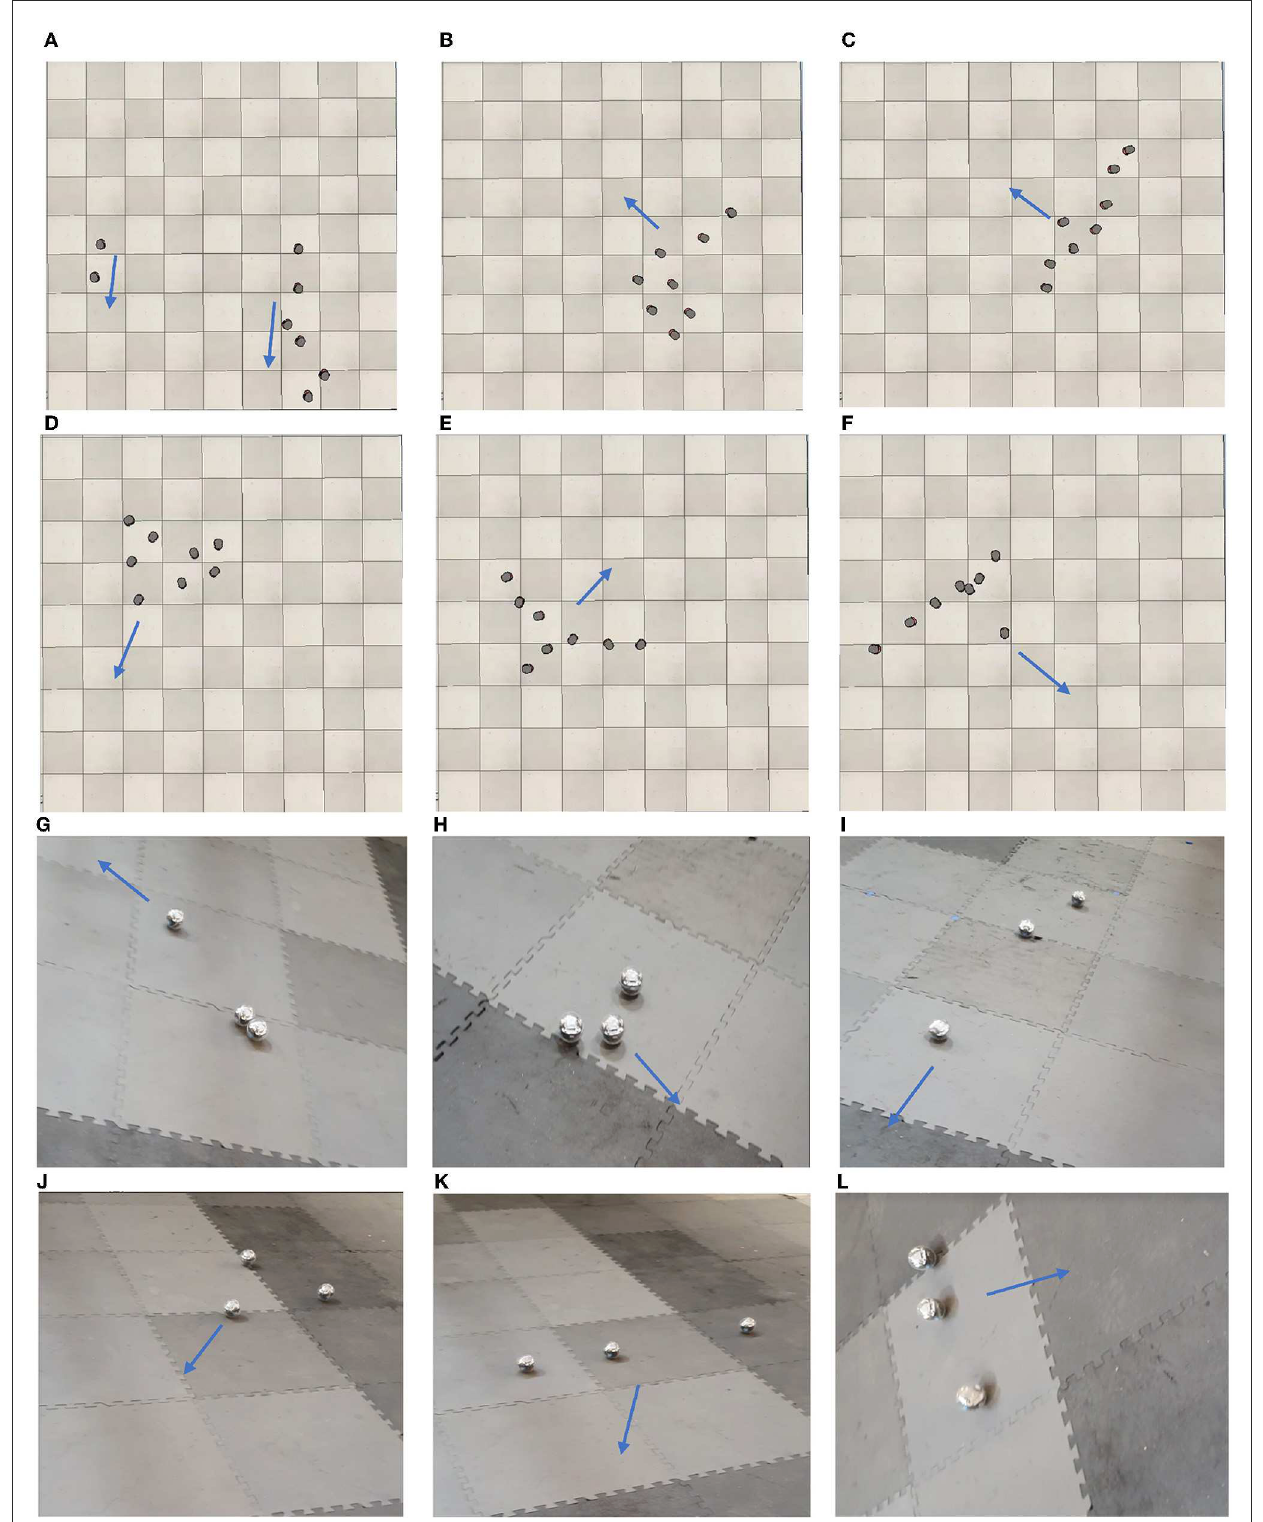
FIGURE10 Formation of automatic tuned behaviors in robots using CoMoT with iterative transfer learning approach (The robots keep the same formation during the movement and the blue arrow shows the direction of movement). (A) Tuned behavior for PR1. (B) Tuned behavior for PR2. (C) Tuned behavior for PR3. (D) Tuned behavior for PR4. (E) Tuned behavior for PR5. (F) Tuned behavior for PR6. (G) Tuned behavior for SR1. (H) Tuned behavior for SR2. (I) Tuned behavior for SR3. (J) Tuned behavior for SR4. (K) Tuned behavior for SR5. (L) Tuned behavior for